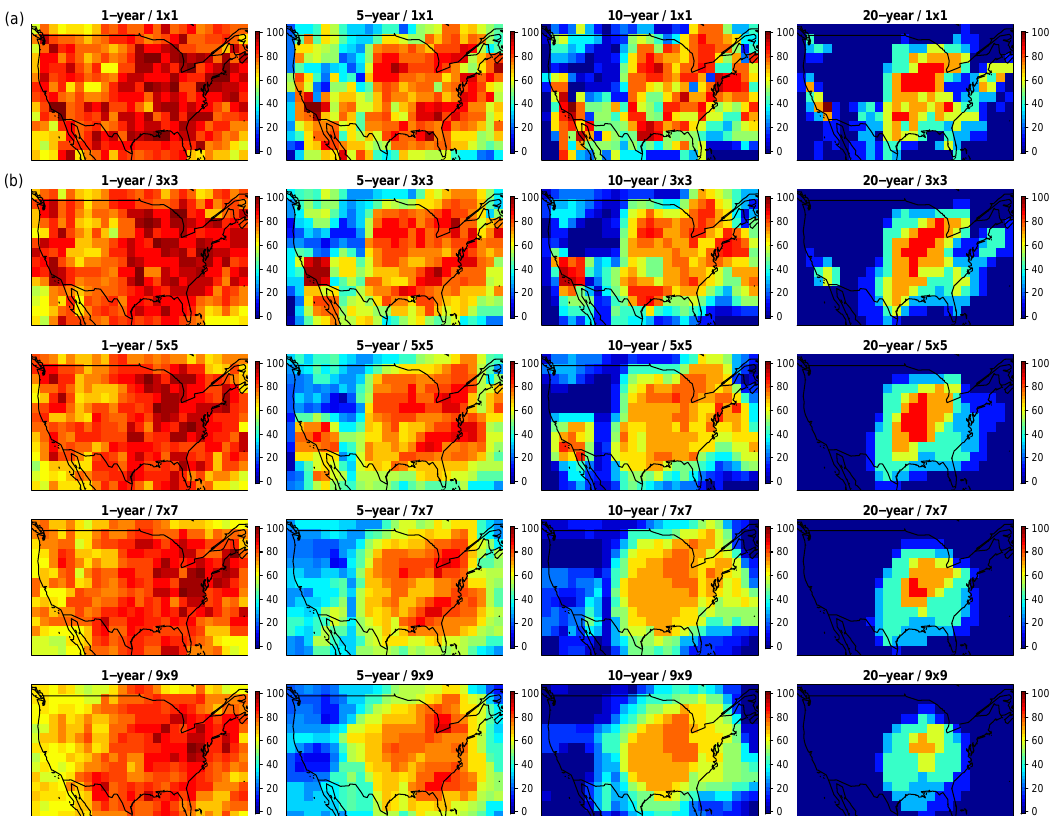
Figure 7. Combined impact of temporal and spatial averaging on reducing ozone variability on the likelihood (%) of exceeding the 0.5ppbv threshold (as in Figs. 5, 6, and S3) for the present-day MOZ_2000 simulation. The top row is the same as in Fig. 6, while the lower rows have averaged the values within a 3 × 3, 5 × 5, 7 × 7, and 9 × 9 grid box surrounding each individual grid